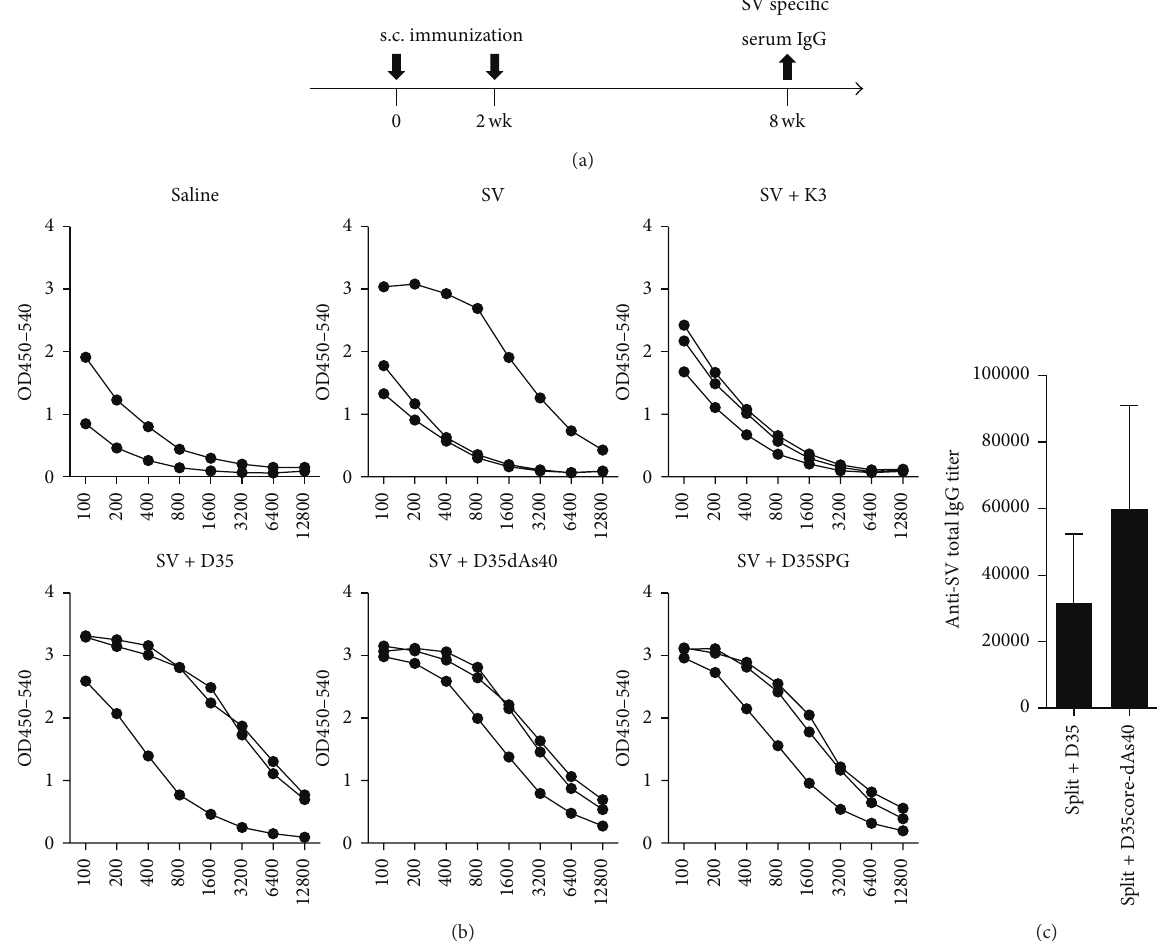
Figure 12: D35-dAs40, D35core-dAs40, and D35-SPG showed better adjuvanticity with influenza SV vaccine in cynomolgus monkeys. (a) Immunization and assay schedule. Six groups of monkeys ( 𝑛 = 2 or 3) were immunized with SV vaccine (A/New Caledonia/20/99, 5 𝜇 g/head) s.c. in a total volume of 500 𝜇 L with or without the indicated adjuvants (4.7nmol each: K3; 30 𝜇 g, D35; 30 𝜇 g, D35-dAs40; 92 𝜇 g, D35-SPG; 92 𝜇 g as D35-dAs40 amount) twice in 2-week intervals. (b) Anti-SV total IgG in sera was determined by ELISA. 𝑋 -axis indicates the serum dilutions. Each line indicates an individual monkey. (c) In a separate experiment, two groups of monkeys ( 𝑛 = 3 ) were immunized with D35 (4.7 nmol = 30 𝜇 g) or D35core-dAs40 (4.7nmol = 80 𝜇 g) as in (a). Four weeks after the first immunization, anti-SV total IgG titers were determined by ELISA. Bar indicates the mean ±